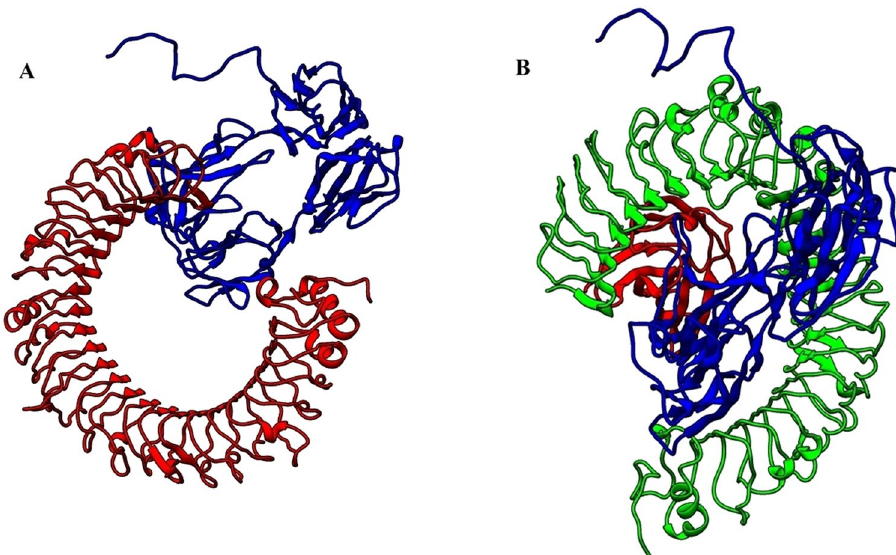
Figure 5. Molecular docking by patchdock server. ( A ) TLR- 3 represented in red color and hemolin protein in blue color, ( B ). Complex from patchdock server showing TLR – 4 in green color, MD2 in red color and hemolin protein in blue